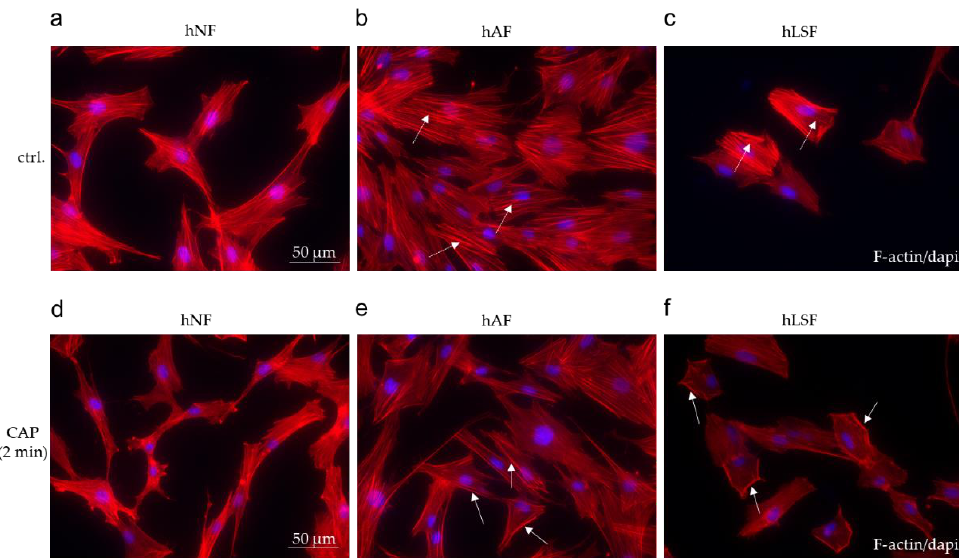
Figure 4. The effect of CAP on the cytoskeletal organization in fibroblasts. Immunofluorescence staining for F-actin/dapi on untreated hNF, hAF and hLSF ( a – c ) and after CAP treatment for 2 min ( d – f ). The dashed arrows in ( b , c ) mark the strong stress fiber formation within the activated fibroblasts. The solid arrows in ( e , f ) indicate the pheripheral localization of the stress fibers after CAP treatment. Scale bar = 50 μm.